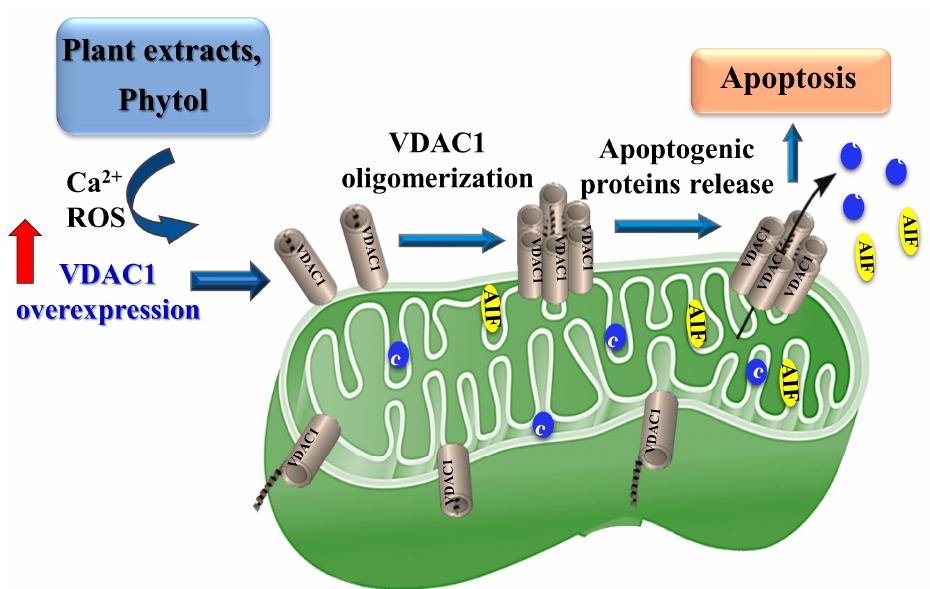
Figure 10. Proposed model for active molecules of plant extracts inducing VDAC1 overexpression and VDAC1 oligomerization leading to apoptosis.